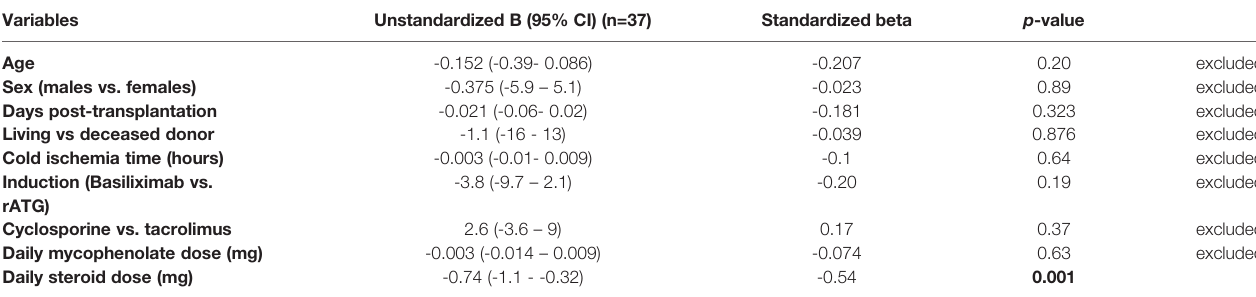
TABLE 6 | Multiple linear regression analysis of the factors affecting absolute CD4+CD25+CD127-Foxp3+ Treg counts in early renal transplant recipients. Variables